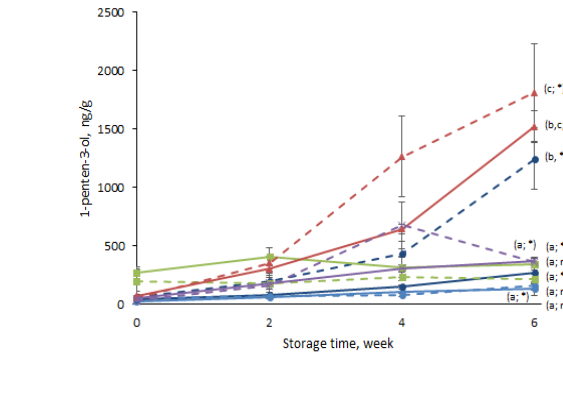
15 of 21 Figure 5. Oxidative stability levels measured using FT-IR of the of the fish-oil-loaded capsules produced by spray-drying or electrospraying (monoaxial and coaxial) during storage.